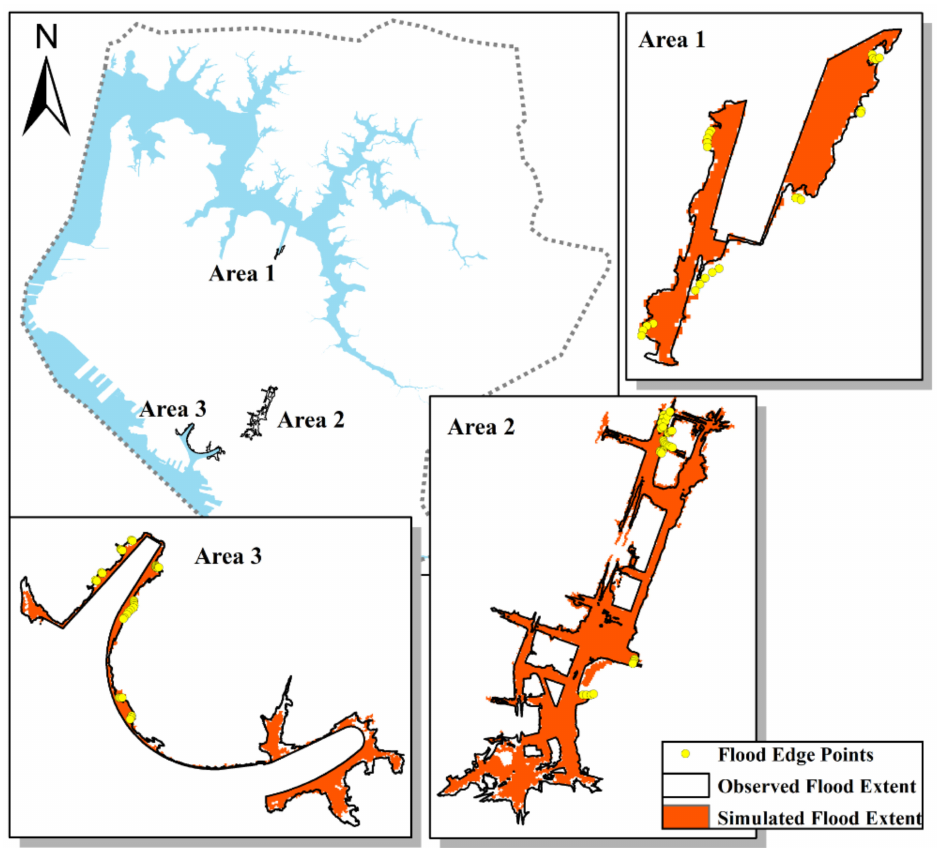
Figure 8. Flood extents extracted from drone footages. Table 2. Flood extent precision, recall, and F1-score in the three evaluation areas. Precision